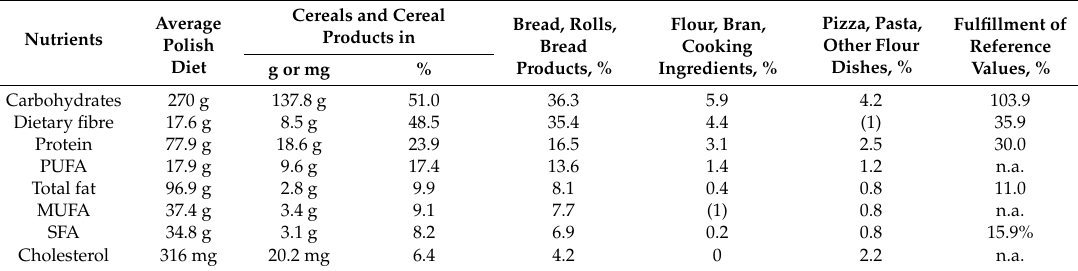
Table 4. Macronutrients, dietary fibre, fatty acids and cholesterol: contribution by cereals and cereal products to the average Polish, top three main groups and fulfillment of the reference values.